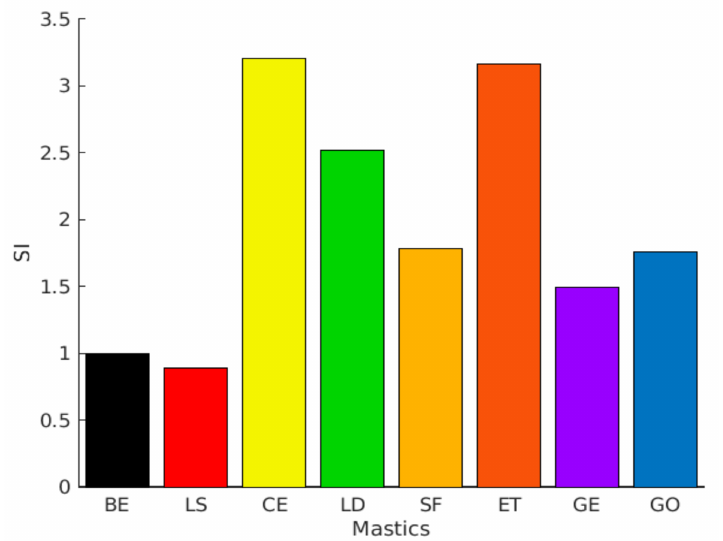
Figure 12. Sti ff ness Index (SI) of di ff erent mastics at 10 Hz under 20 ◦